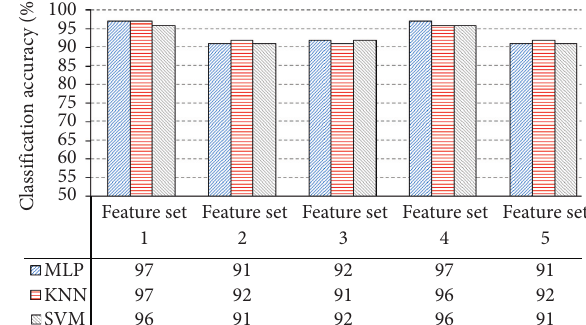
Figure 8: The average accuracy of different feature sets using individual